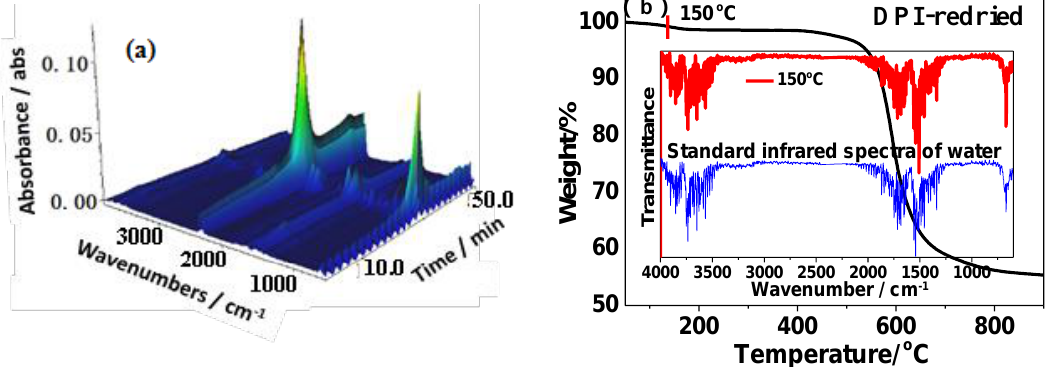
Figure 7. TG-FTIR curves of the DPI-redried film. ( a ) TG-FTIR curves; ( b ) FT-IR spectrum of the volatiles at 150 °C.